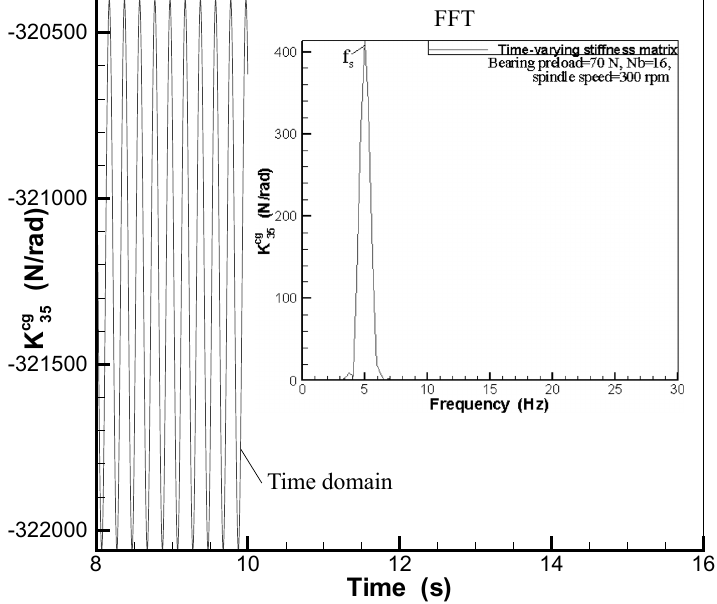
Fig. 13. Time domain and FFT of K cg 35 . Time varying stiffness matrix is used. Same input data as in Fig. 12 except that Nb =